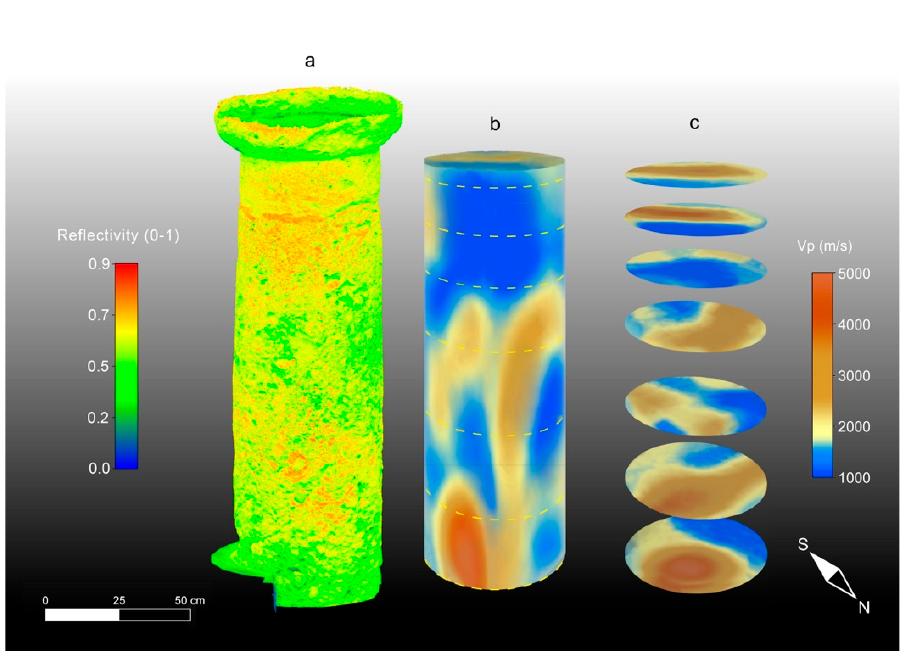
Figure 14. High-resolution 3D models of column 1. ( a ) TLS reflectivity model; ( b ) ultrasonic tomog- raphy; ( c ) tomographic slices.